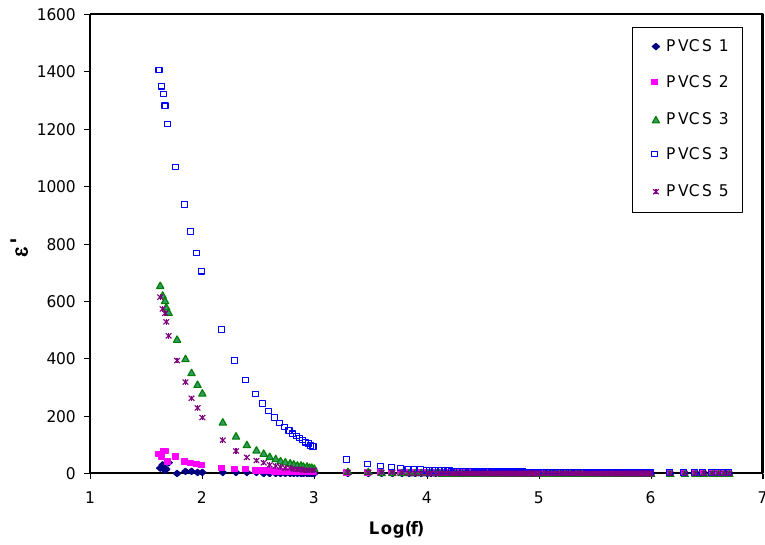
Figure 8. Dielectric constant versus log (f) for all polymer blend electrolytes.